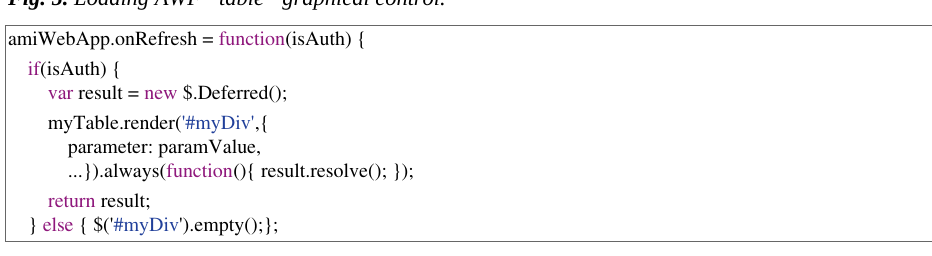
Fig. 6. Rendering AWF “table” graphical control.